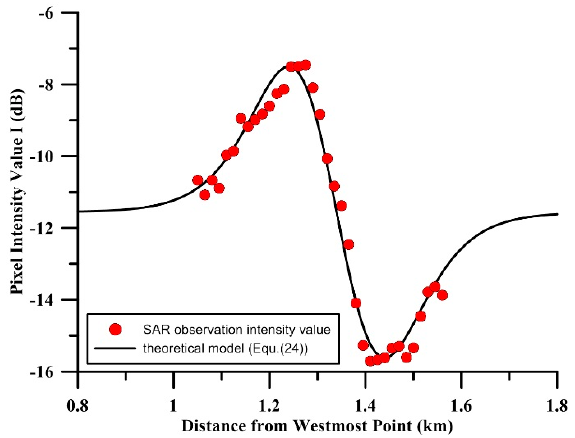
Figure 8. Curve fittings of the theoretical model (Equation (24)) (the black line) to the pixel observation intensity value (red point) of the soliton 𝐿1 along transect AA’ in Figure